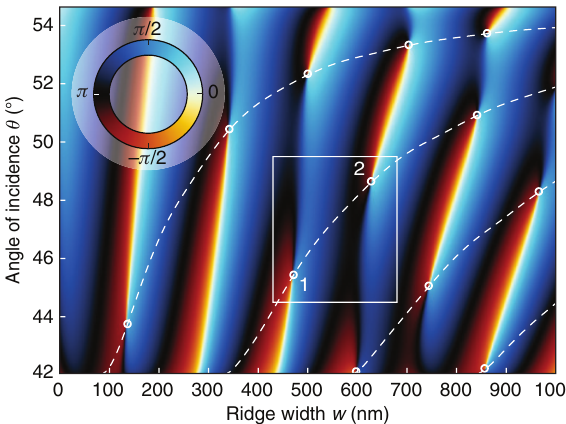
Figure 4: Phase of arg P vs. ridge width w and angle of incidence θ . As a guide to the eyes, the dashed lines show the dispersion of the quasi-TM modes of the ridge. White circles show the BIC positions predicted by the coupled-wave